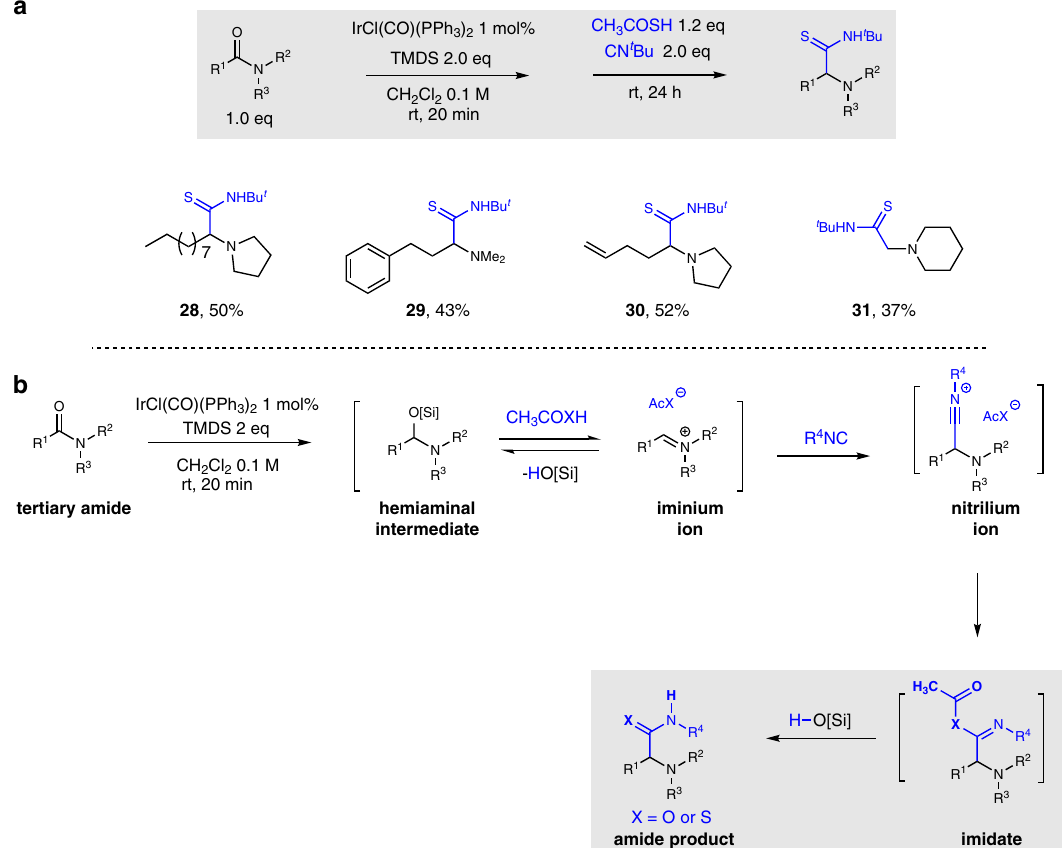
Fig. 3 Synthesis of α -amino thioamides and mechanism of the reductive Ugi reactions. a Synthesis of α -amino thioamide derivatives from tertiary amides. Standard condition: amide 0.3 mmol, IrCl(CO)(PPh 3 ) 2 1 mol%, TMDS 0.6 mmol, CH 2 Cl 2 3 mL, tert -butyl isocyanide 0.6 mmol, CH 3 COSH 0.36 mmol; yields of puri fi ed product following fl ash column chromatography. b Proposed mechanism of the reductive Ugi